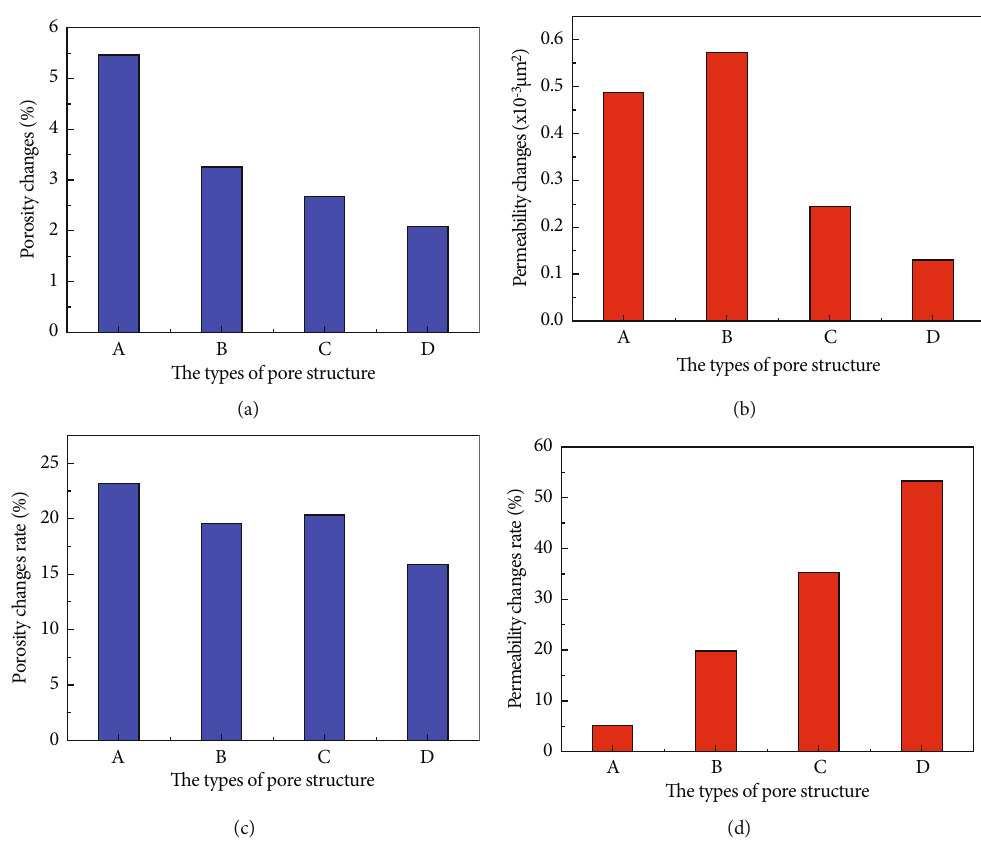
Figure 9: The relationship between pore structure types and porosity permeability before and after Soxhlet extraction. (a) Pore structure type and porosity changes. (b) Pore structure type and permeability changes. (c) Pore structure type and porosity change rate. (d) Pore structure type and permeability change